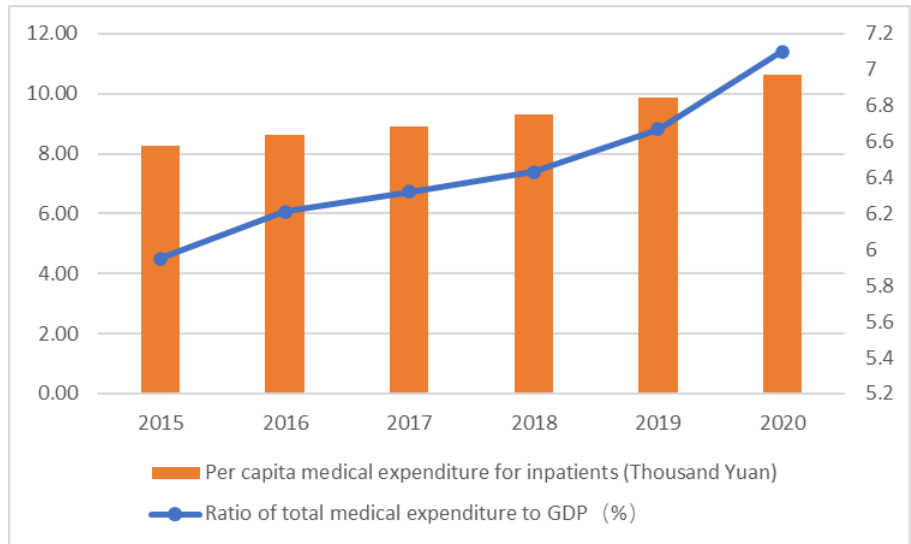
Figure 1. Burden of medical expenditure in China from 2015 to 2020. Source: China Health Statistical Yearbook 2021 .